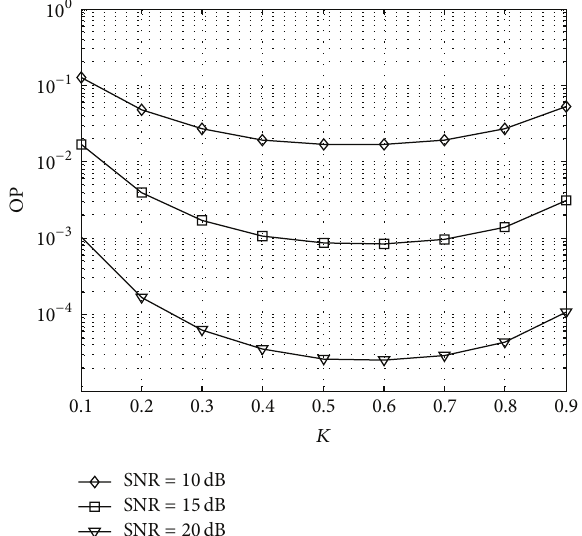
Figure 3: The effect of the power-allocation parameter 𝐾 on the OP performance.